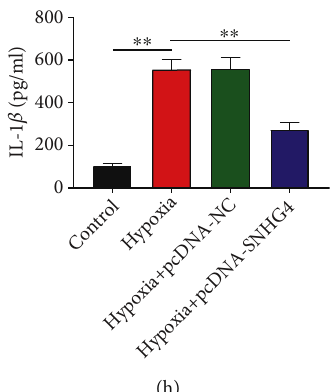
Figure 1: Overexpression of SNHG4 promotes the viability and represses the apoptosis and in fl ammation of hypoxia-induced H9c2 cells. (a) The expression of SNHG4 in hypoxia-induced H9c2 cells was detected by qRT-PCR. (b) The expression of SNHG4 in hypoxia-induced H9c2 cells transfected with pcDNA-SNHG4/pcDNA-NC was detected by qRT-PCR. (c) Cell viability (OD450) was measured by MTT assay. (d) Caspase-3 activity. (e) The protein expression of Bax and Bcl-2 were measured by western blot. (f – h) The levels of TNF- α , IL-6, and IL-1 β were measured by ELISA. ∗∗ P < 0 : 01 .